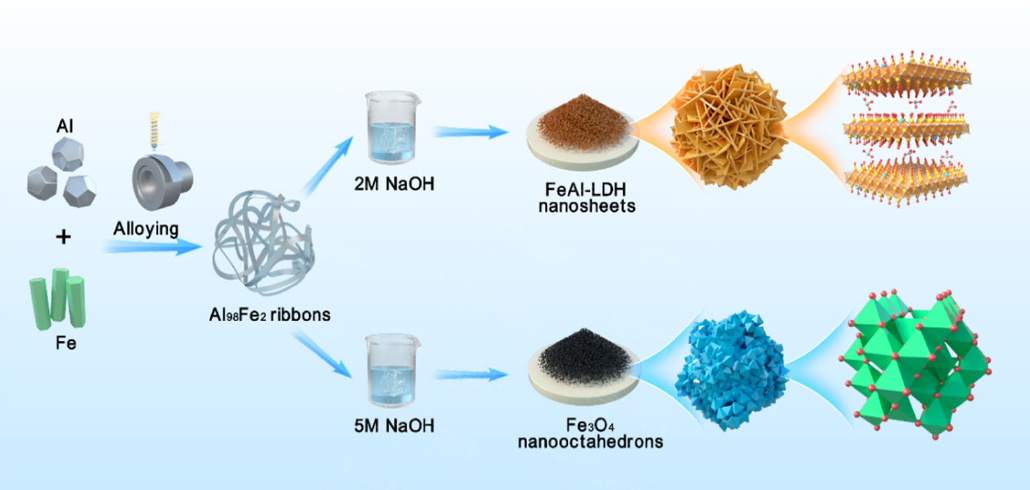
Figure 1. Schematic illustration showing the corrosion-engineered fabrication process of the FeAl- LDH nanosheets and Fe 3 O 4 nanooctahedrons.